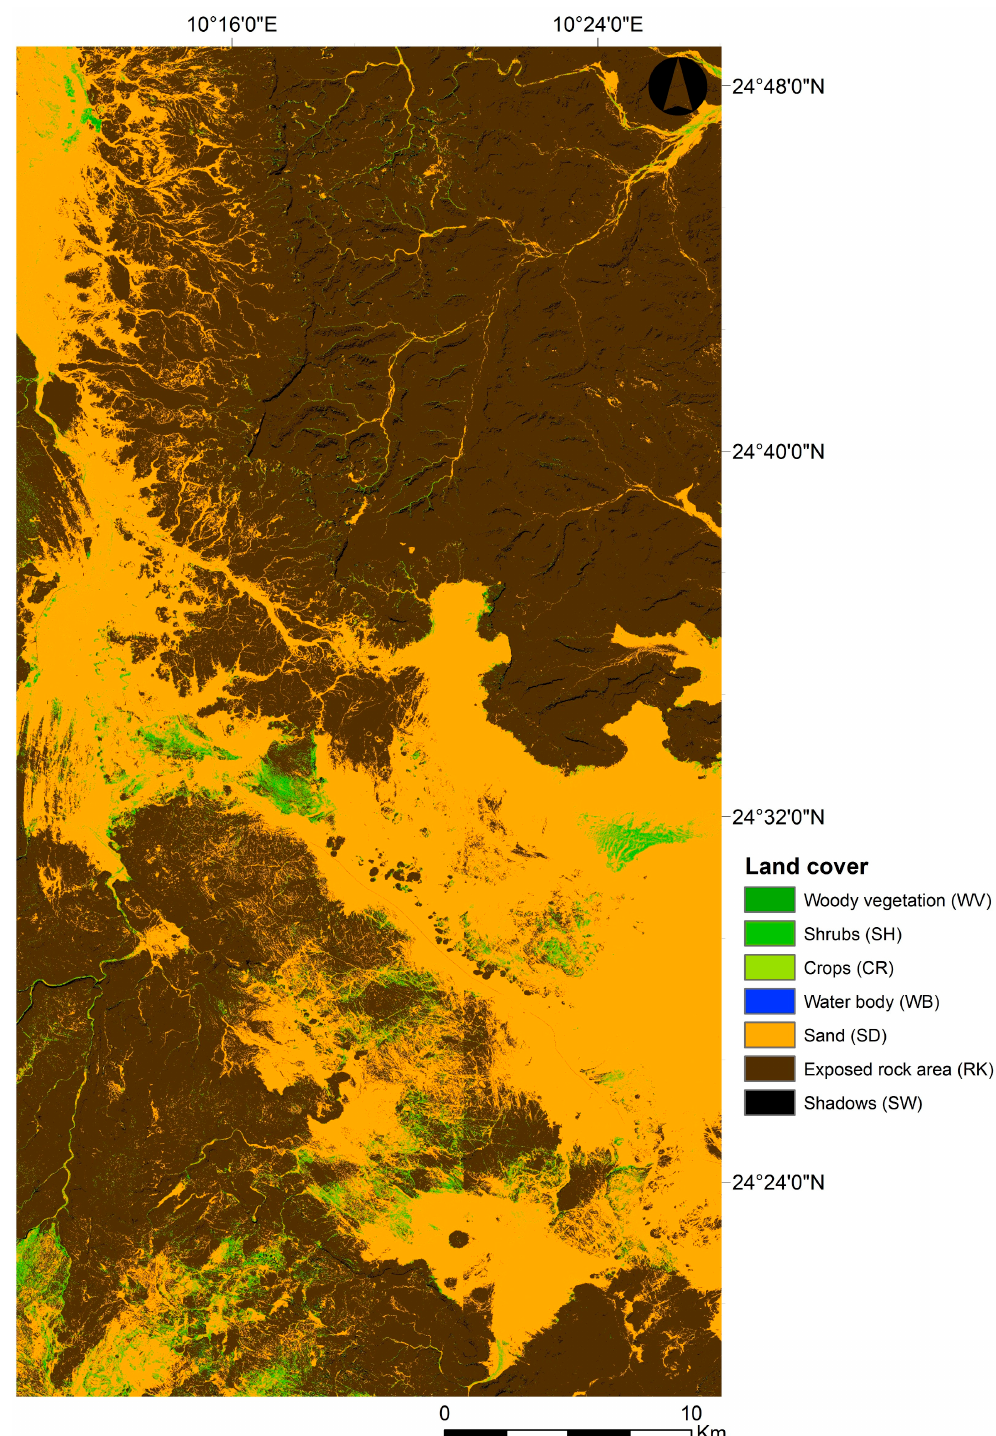
Figure 5. Land use/land cover (LULC) map generated using a RF classifier (Satellite image courtesy of the DigitalGlobe Foundation).